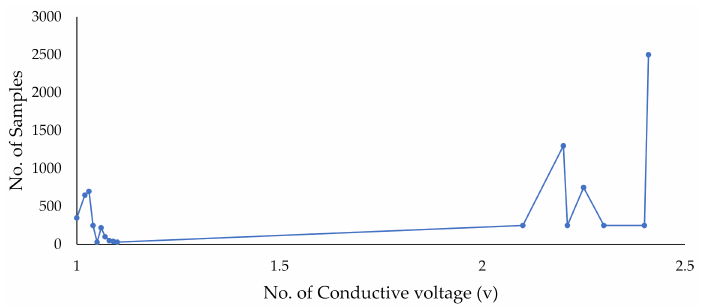
Figure 6. Graph of the first case with two